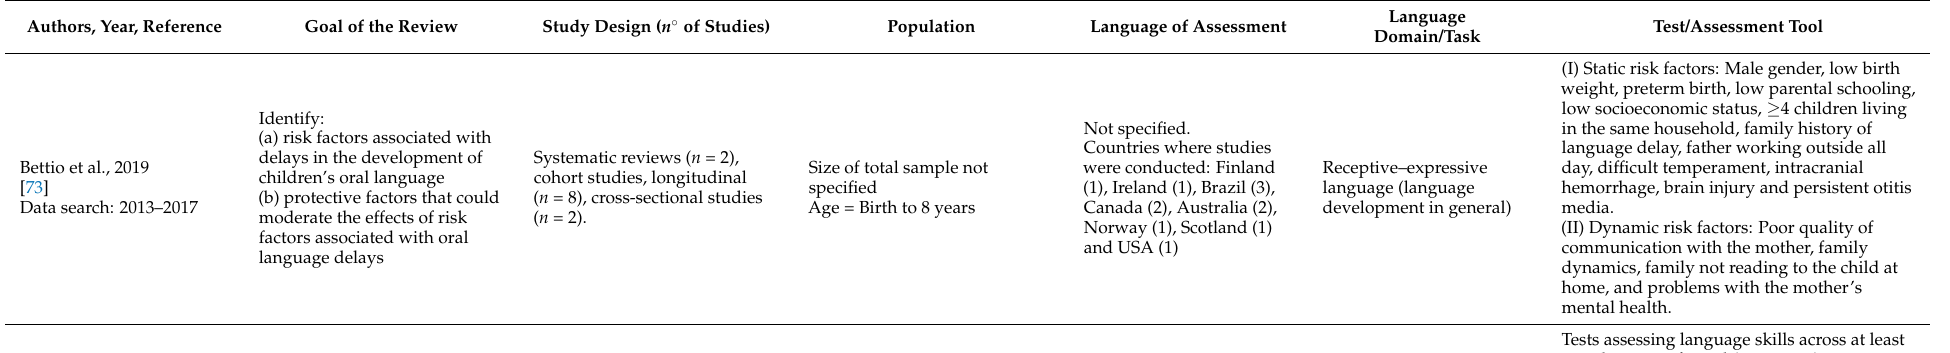
Table A2. Characteristics of the 10 selected systematic